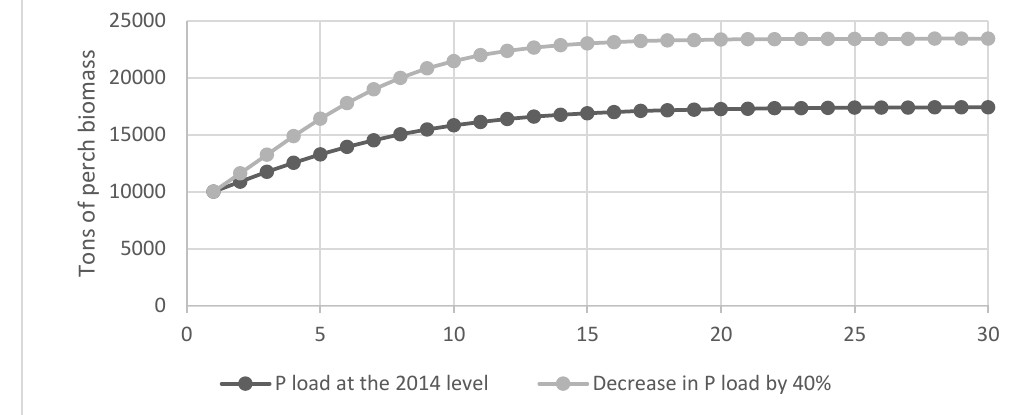
Fig. 3. Predicted development in perch population (ton biomass) off the east coast of Sweden in different phosphorus (P) load